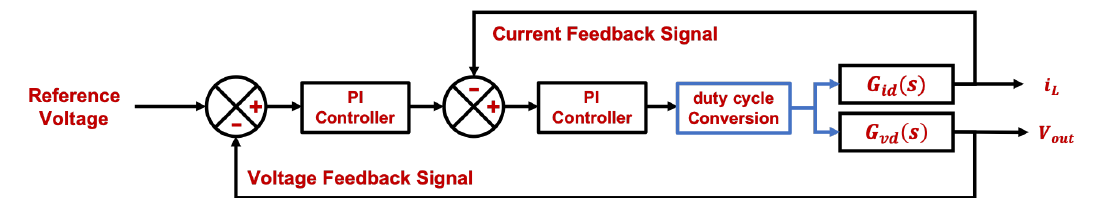
Figure 11. Cascade controller scheme for voltage and current in a buck converter, using the small-signal model transfer